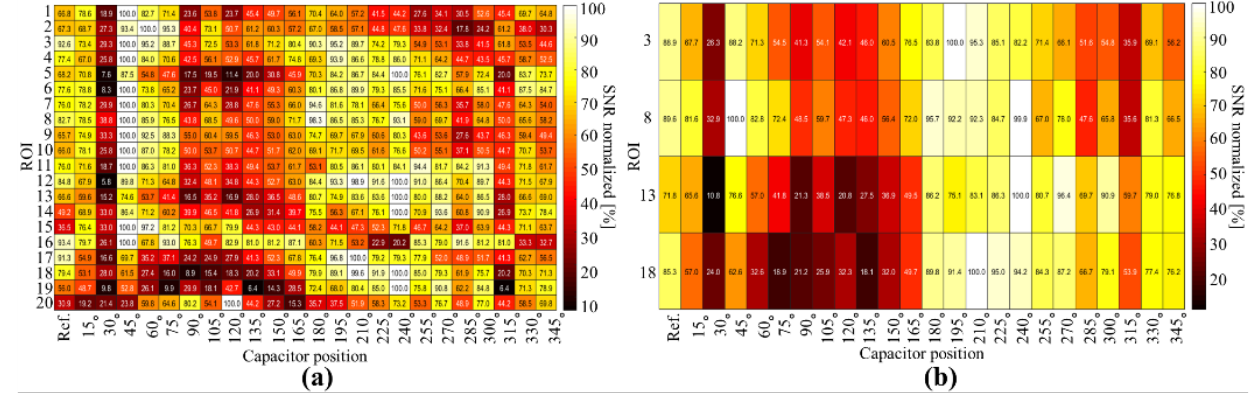
Figure 13. Mean normalized SNR values for each ROIs and for all tested coil configurations in ( a ) axial and ( b ) sagittal views. ( a ) axial and ( b ) sagittal